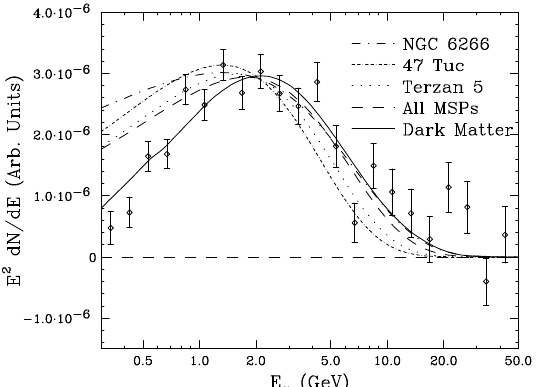
Figure 16: Observed spectrum of the GeV excess in the analysis of Ref. [ 199 ] , com- pared to spectra of observed millisecond pulsars and several globular clusters (whose gamma-ray emission is thought to be dominated by millisecond pulsars. Reproduced from Ref. [ 199 ] ; see that work for